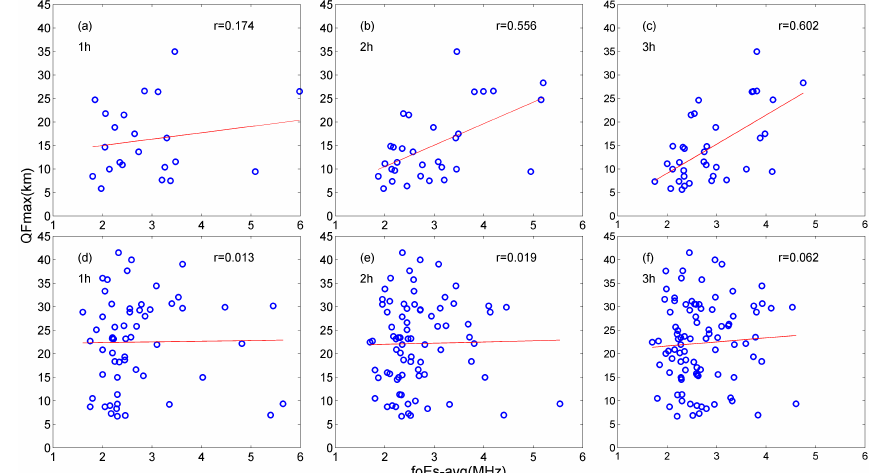
Figure 6. Scatter plots of maximum QF (QFmax) and average of fo Es ( fo Es-avg) in 1 (a, d) , 2 (b, e) and 3 (c, f) hours before QF events under quiet conditions (the sum of daily Kp, P Kp<24) during (a–c) June solstice and (d–f) equinox. The red line in each panel is the fitting of all data. The correlation coefficient is shown in the right top of each